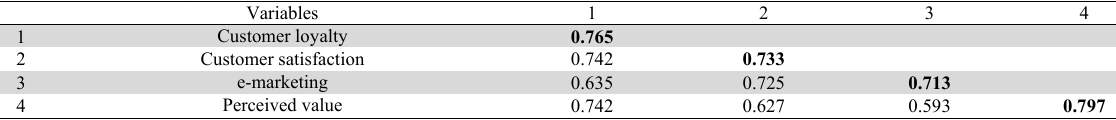
Furnell Larcker Analysis